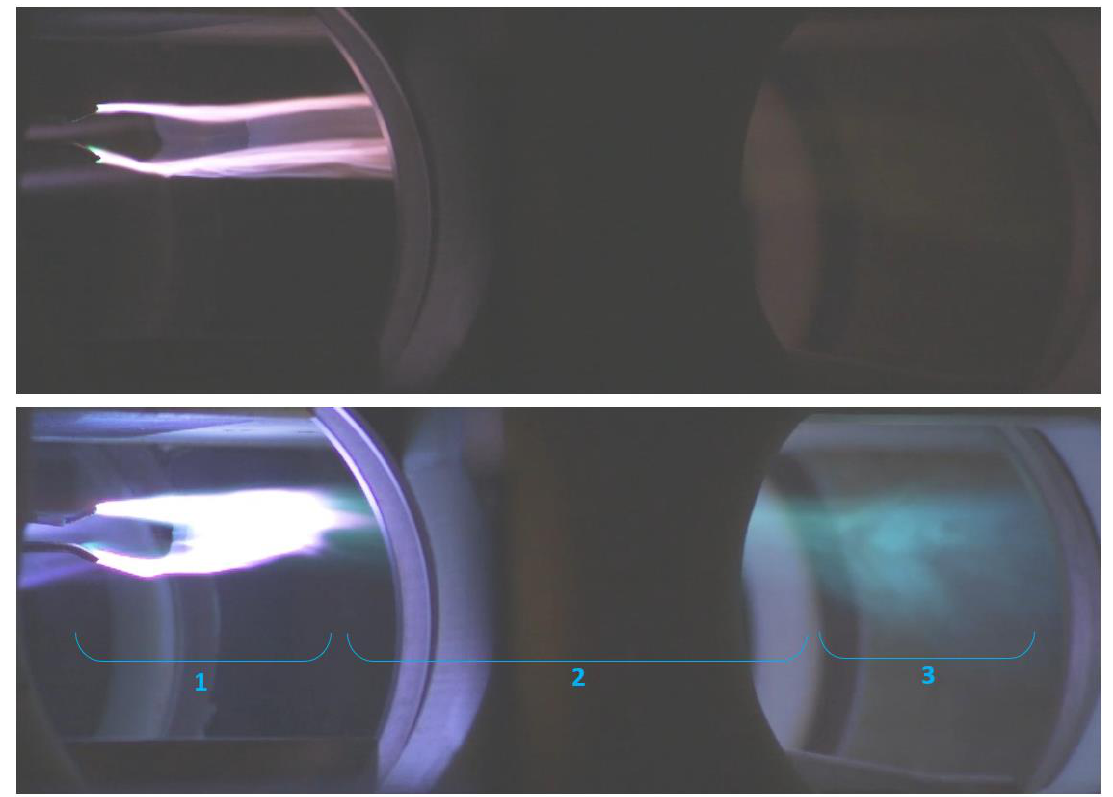
Figure 11. Visualization of the experiment using Phantom VEO 410, top image—discharge into supersonic airflow and bottom image—combustion: 1—plasma region, 2—«cold» flame, 3—hot flame.